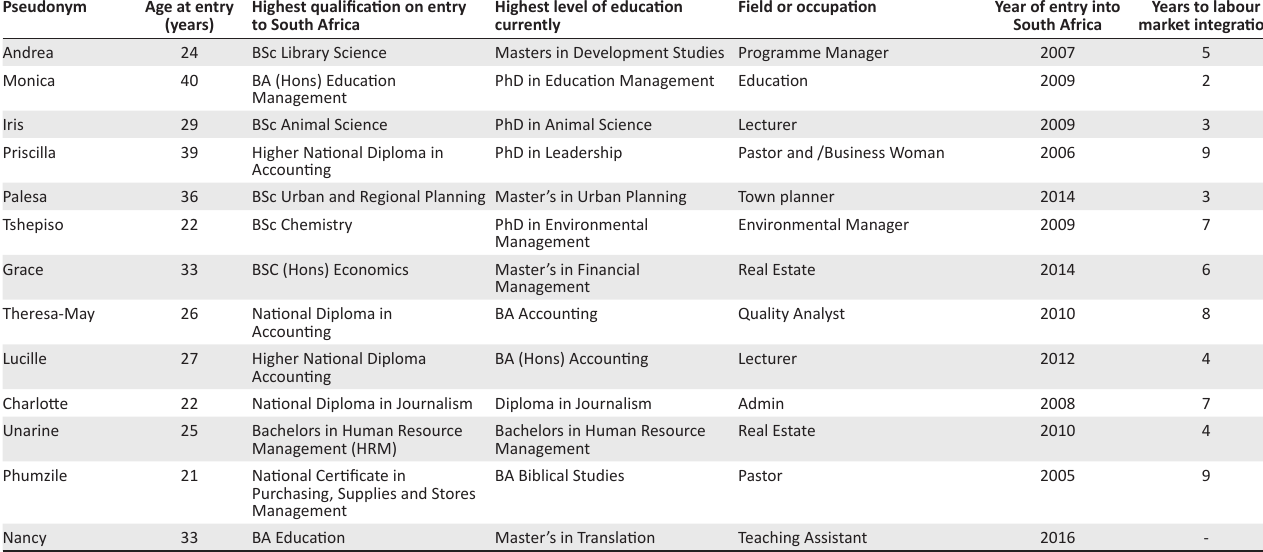
TABLE 1: Characteristics of the research